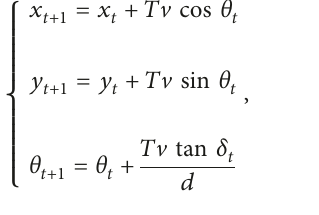
Figure 3: Target angle.